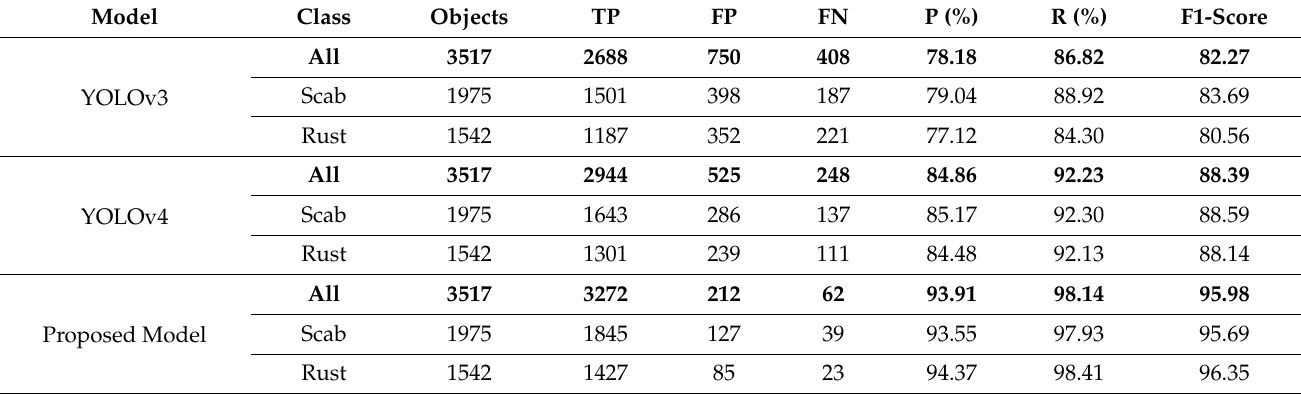
Figure 7. Comparison of validation loss curves between YOLOv3, YOLOv4, and proposed detec- tion model. Table 5. Comparison of detection results between YOLOv3, YOLOv4, and proposed model on the test dataset.